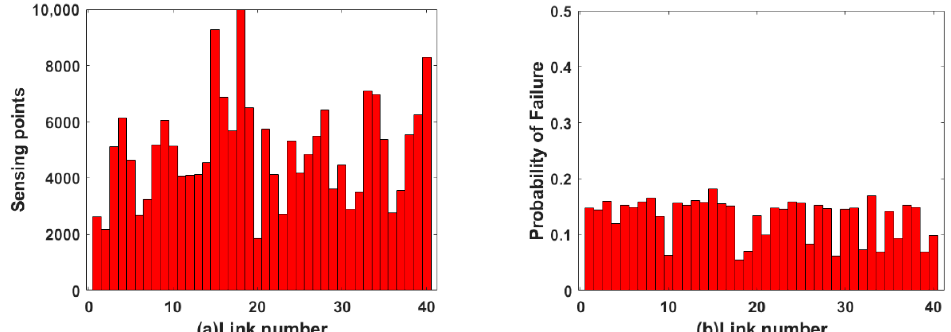
Figure 6. ( a ) The sensing points distribution in non-uniform allocation mode; ( b ) The distribution of link failure probability in non-uniform allocation mode.